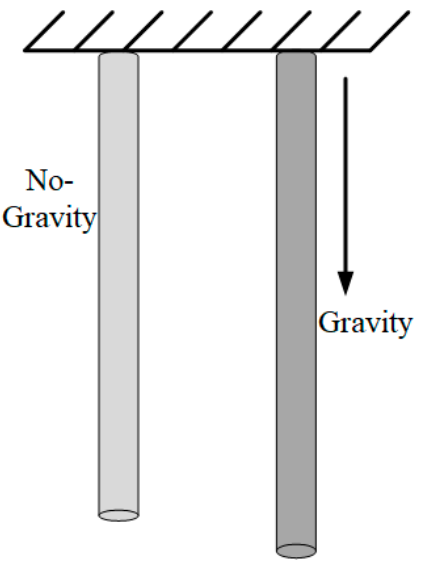
Figure 4. Deformation process of the twisting module obtained with ABAQUS software.